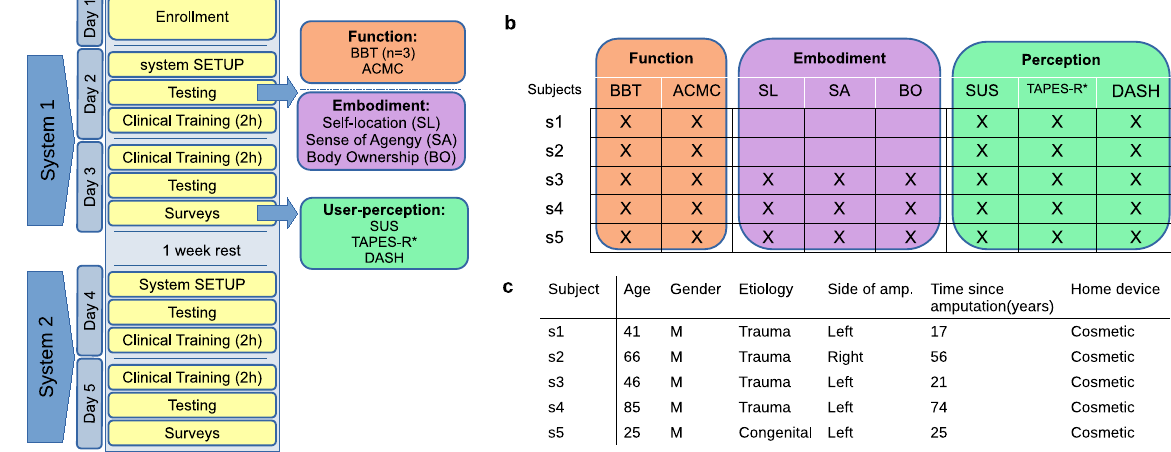
Figure 7. Experimental protocol. ( a ) Shows a schematic description of the experimental protocol. After the enrolment, each subject conducted 2 experimental sessions divided by a week break. Each session was devoted to the evaluation of one of the two systems (rigid and soft), usually comparing data from pre- and post-training. ( b ) Presents a table that marks the test and survey performed by each participant (s i ) included in the study. ( c ) Gives the subjects